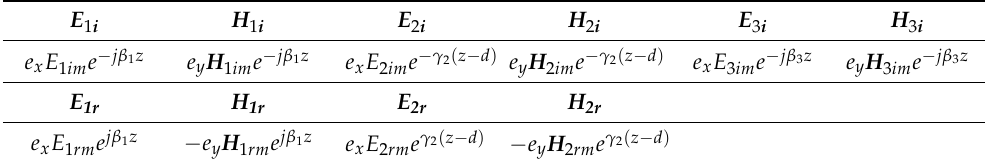
Figure 3. Electromagnetic field distribution. Table 1. Expressions of electromagnetic